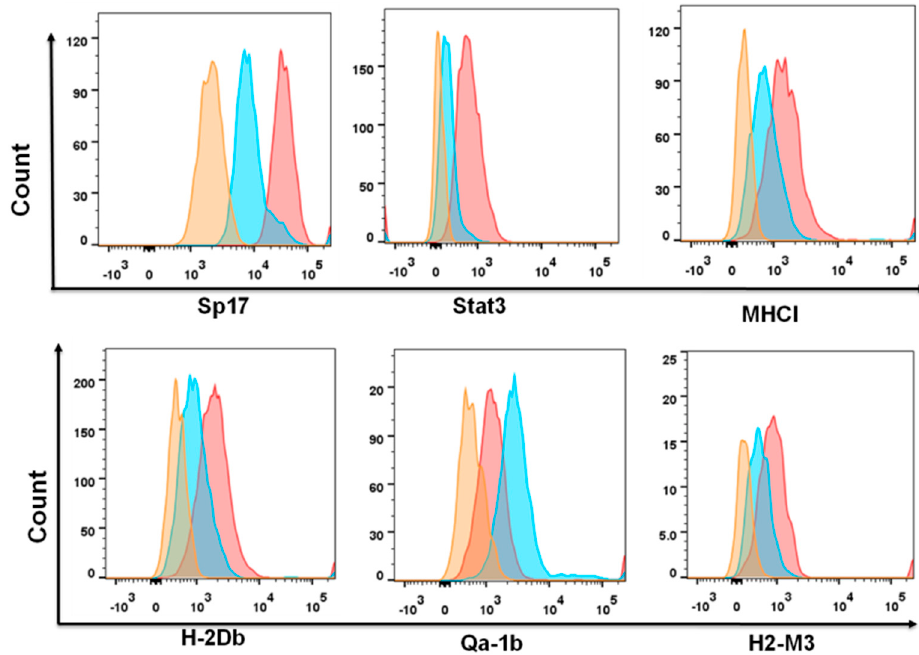
Figure 4. Sp17 and immune marker expression differs between PD-L1 + MHCII − and PD-L1 − MHCII + populations of ID8 cells. Original (non-clonal selected) ID8 cells were collected and stained for the expression of PD-L1, MHCII, Sp17, STAT3, H2-Db, Qa-1b, and H2-M3. Marker expression between PD-L1 + MHCII − (red) and PD-L1 − MHCII + (blue) populations was analyzed (isotype control, orange). Data is shown as histograms of each marker expression between these two populations.